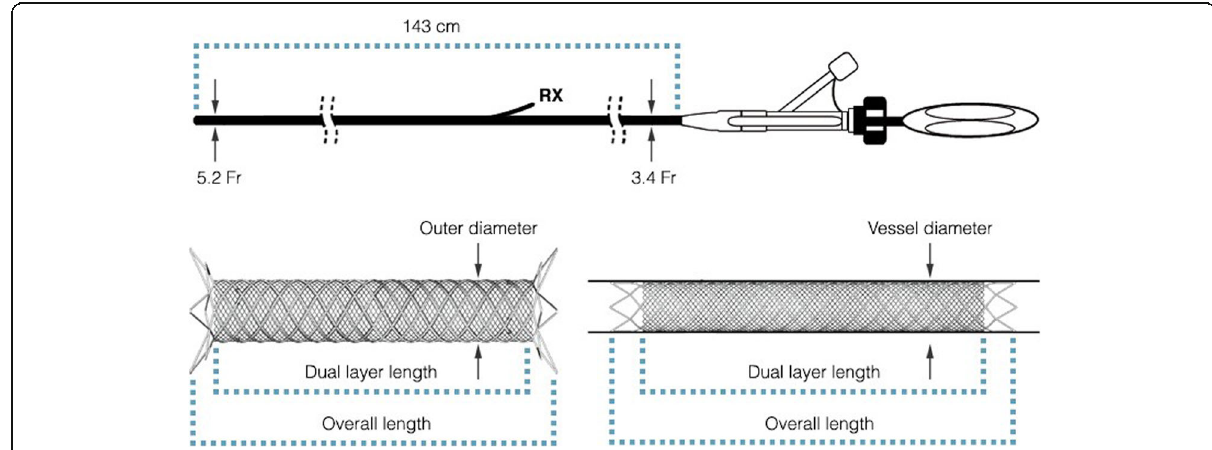
Fig. 5 Unconstrained and deployed CASPER stents demonstrating the dual layer design and working length. The stent comes on a 5.2Fr 143 cm deployment shaft with a rapid exchange (RX) system allowing for improved navigability into tortuous